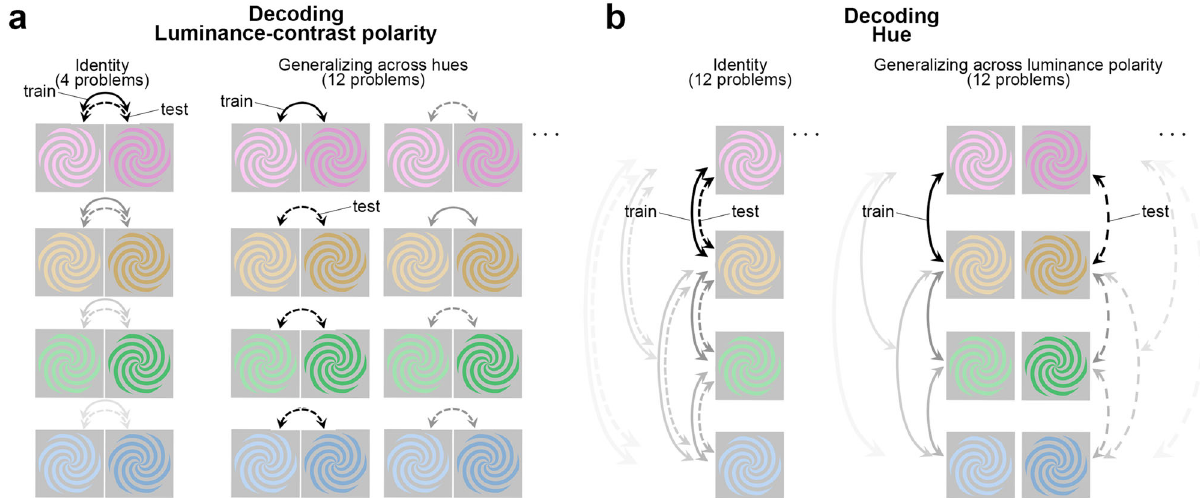
Fig. 1 Decoding luminance polarity and hue from MEG data: approach. a Decoding luminance polarity. Participants were shown four hues that varied in luminance polarity (light/dark). Classi fi ers were trained (solid arrows) and tested (dashed arrows) using stimuli of the same hue (identity problems) or different hue (generalization problems) to determine the extent to which the MEG response to a given color is informative of the luminance polarity carried by the same hue (4 identity problems) or by other hues (12 generalizing-across-hue problems). Each binary classi fi er was trained to distinguish whether a light or dark stimulus had been presented, given patterns of magnetoencephalography (MEG) sensor activations. For the four identity problems, classi fi ers were trained and tested on brain responses to the same hue (all four identity problems are illustrated in the graphic). For the generalization problems, classi fi ers were trained and tested on brain responses to different hues (half of the 12 generalizing-across-hue problems are illustrated). In the graphic, solid lines indicate comparisons used for training and dashed lines indicate comparisons used for testing; line shading distinguishes different problems. b Decoding hue. Format as in panel a . For stimuli of a given luminance polarity (e.g., dark), a binary classi fi er was trained to determine which of two hues (e.g., pink or orange) had been presented. The classi fi ers were then tested, again on held-out trials in which the luminance polarity (e.g., dark) was the same as at train time (12 identity problems) or in which the luminance polarity was opposite (e.g., light), requiring generalization of hue across luminance polarity (12 generalizing-across-luminance-polarity